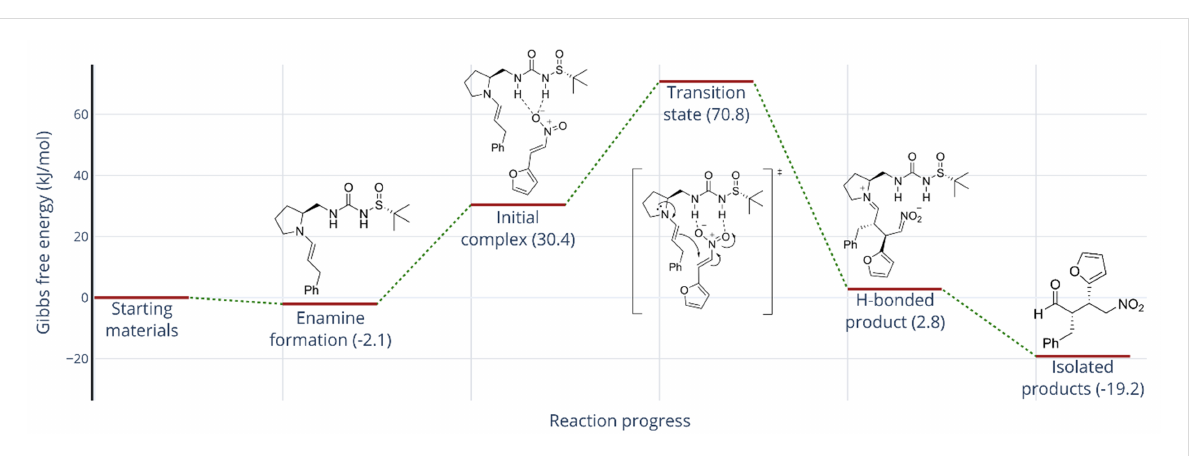
Figure 4: DFT-calculated (PBEh-3c/def2-SV(P)//M06-2X/def2-TZVP) reaction profile for the Michael addition of 3-phenylpropanal ( 6c ) and nitroalkene 9 using catalyst ( S,R )- C2